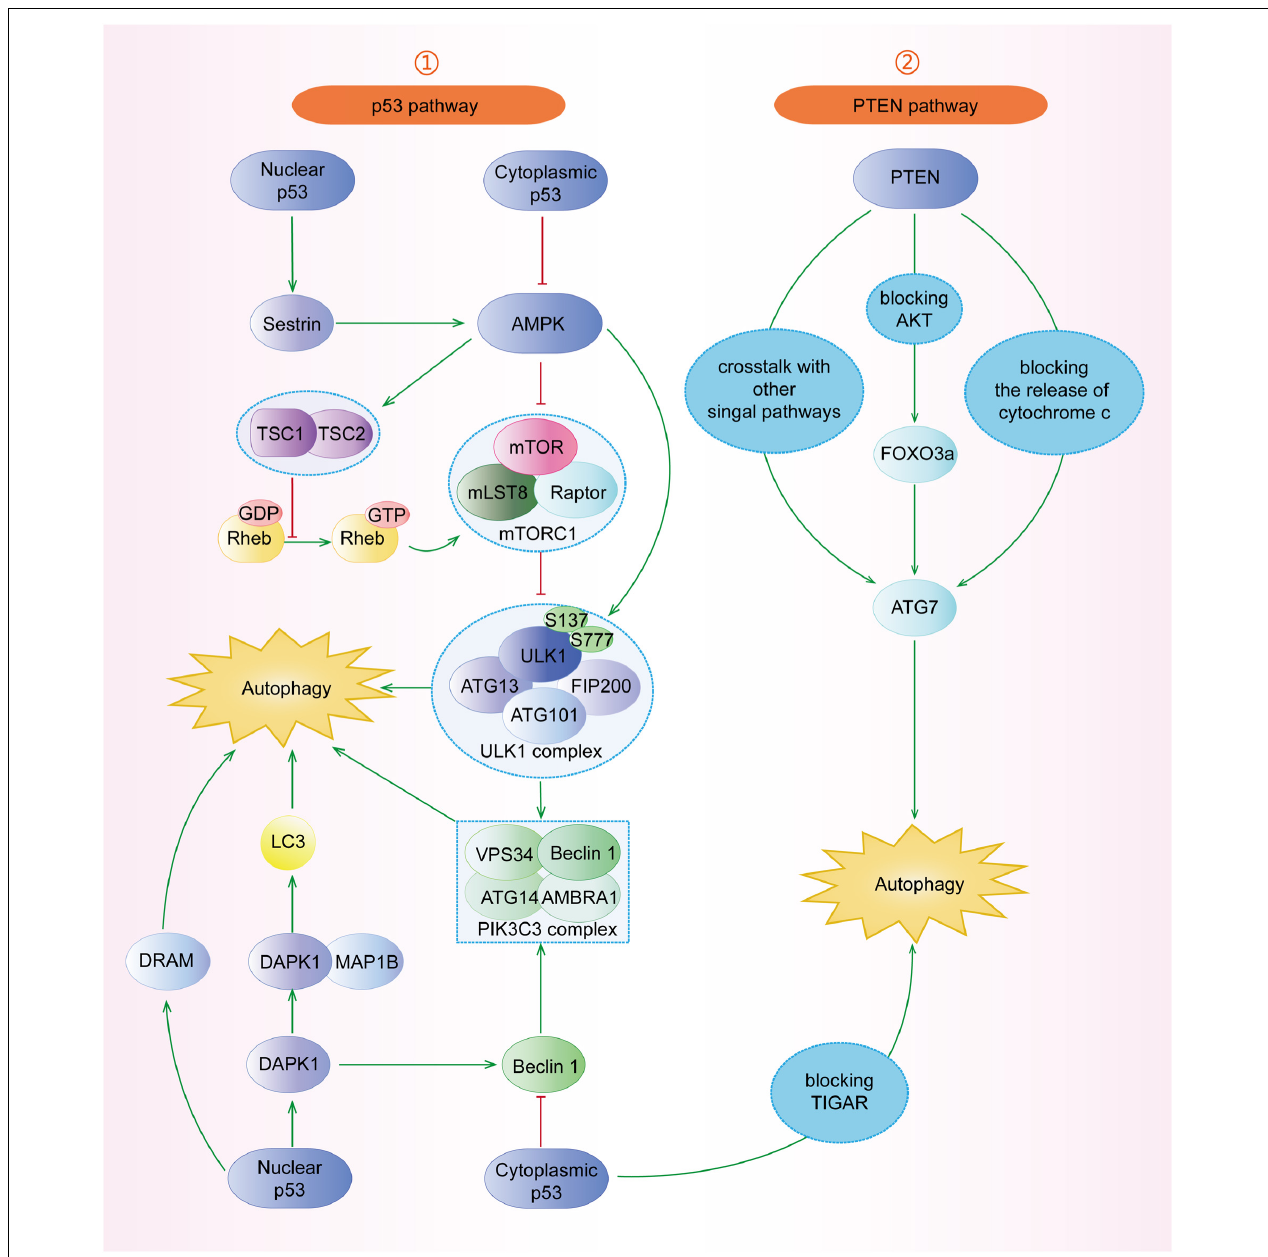
FIGURE 4 | The roles of p53 and PTEN signaling pathways in the regulation of autophagy. (1) p53 pathway: nuclear p53 can induce autophagy through Sestrin1/Sestrin2-AMPK-TSC1/TSC2 complex-mTOR. DRAM is a downstream target of p53 facilitating autophagy. Furthermore, p53 can induce DAPK1 to phosphorylate Beclin-1 or bind to MAP1B to inhibit autophagy. However, cytoplasmic p53 blocks AMPK, TIGAR, and Beclin-1 to inhibit autophagy. (2) PTEN pathway: PTEN has crosstalk with other signal pathways. PTEN can induce autophagy through the PTEN/AKT/FOXO3a/Atg7 pathway, independent of mTOR and Beclin-1. Additionally, PTEN blocks the release of cytochrome c to induce